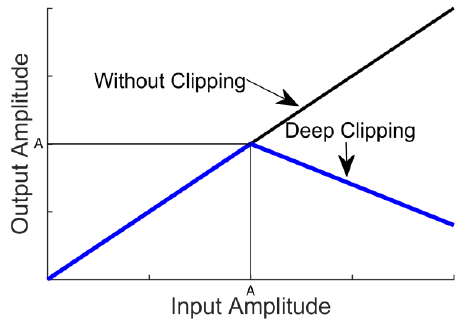
Figure 3. Deep Clipping function.